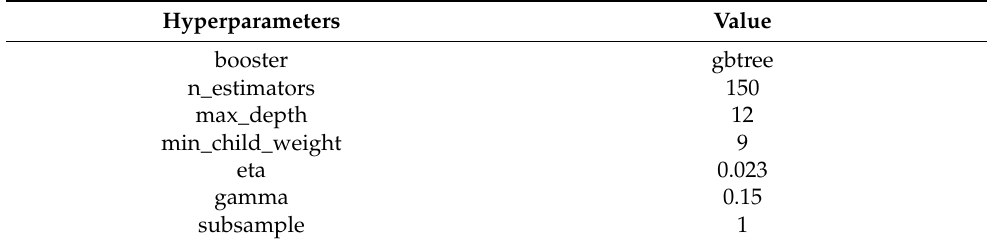
Table 3. Summary of optimal hyperparameter settings for the XGBoost model.